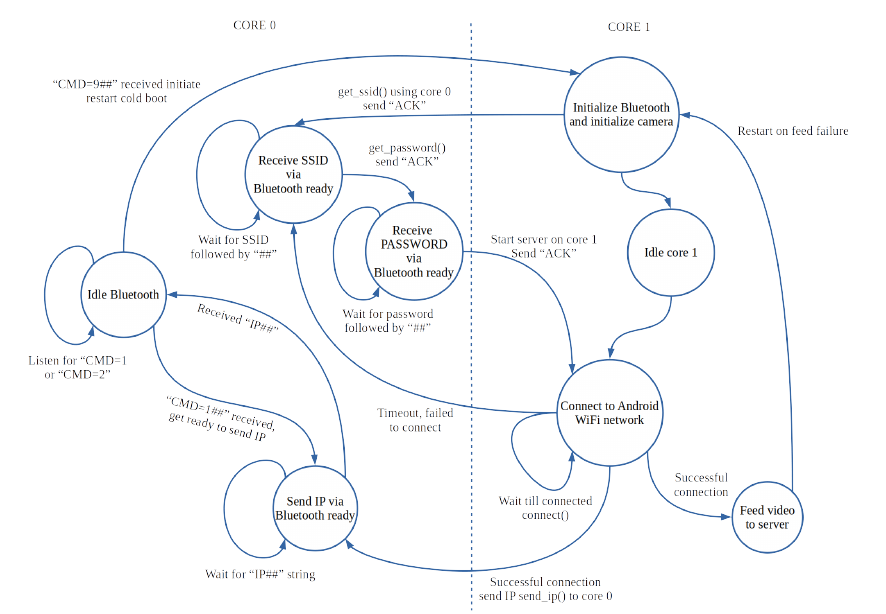
Figure 6. State machine of two cores for communication and dedicated video feed.